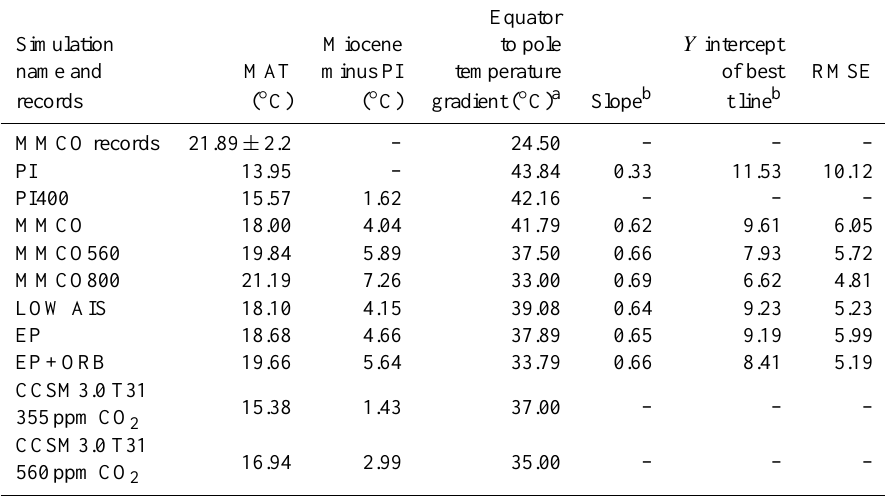
Table 2. Compilation of model simulation names, imposed boundary condition changes, model and proxy MAT values, Equator to pole temperature gradient values, and model–data pointwise comparison statistics.